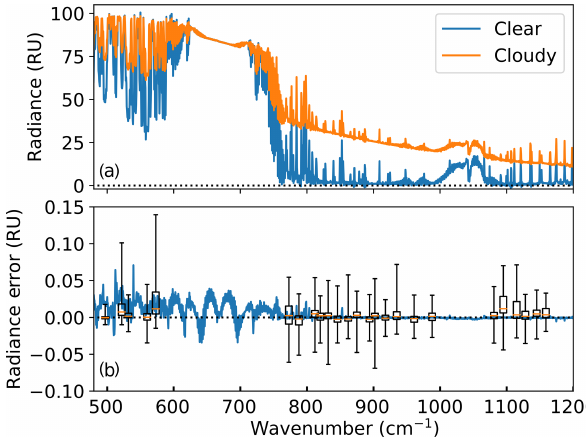
Figure 1. (a) Clear- and cloudy-sky downwelling radiance (1RU = 1mW/(m 2 srcm − 1 )) for a typical polar atmosphere at a resolution of 0.5cm − 1 . (b) Model errors (model–true) in down- welling radiances for the clear-sky radiance shown in (a) (blue solid line), and box-and-whisker plots of model errors for all radiances, averaged in microwindows (horizontal lines give the median, boxes give the 1st and 3rd quartiles, and whiskers give the